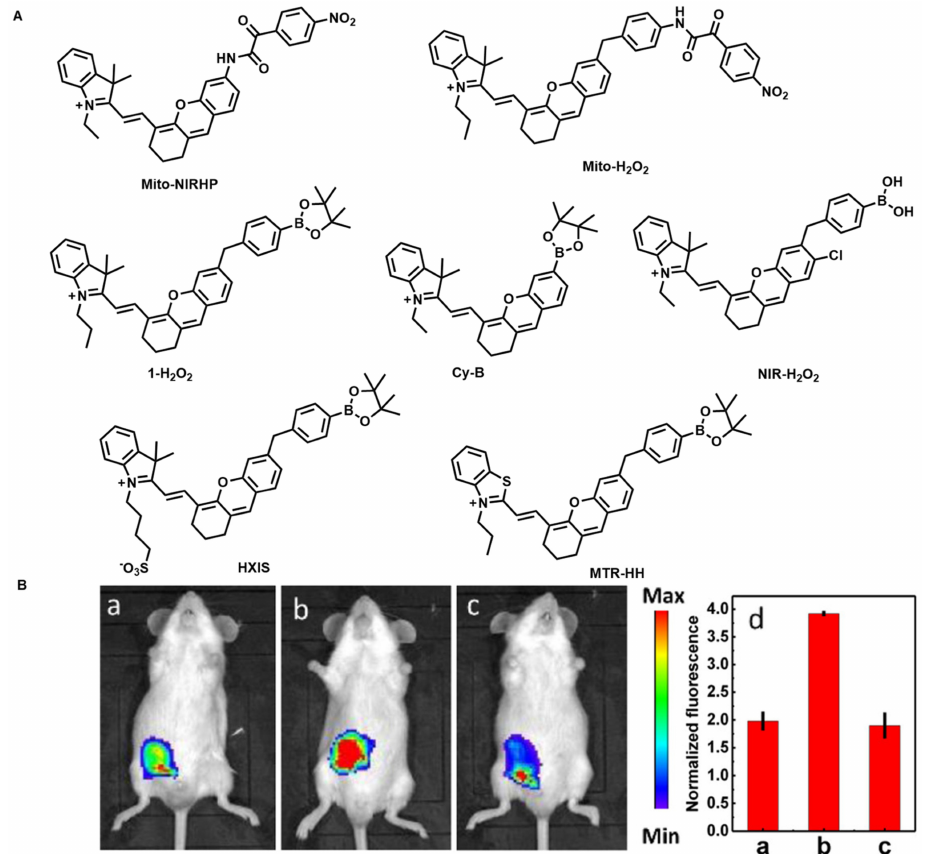
Figure 6. Chemical structures of fluorescent probes ( A ) for H 2 O 2 . ( B ) Fluorescence imaging (pseu- docolor) of H 2 O 2 in Kunming mice. ( a ) Only the Mito-NIRHP (20 µ M, 100 µ L) was injected as control. ( b ) Mouse pretreated with rotenone for 1 h and then injected with Mito-NIRHP. ( c ) Mouse successively injected with rotenone, NAC, and Mito-NIRHP. ( d ) Relative fluorescence intensities of (a)–(c). The excitation filter was 660 nm, and the emission filter was 710 nm. Reproduced with permission from Ref. [20]. Copyright (2016) American Chemical